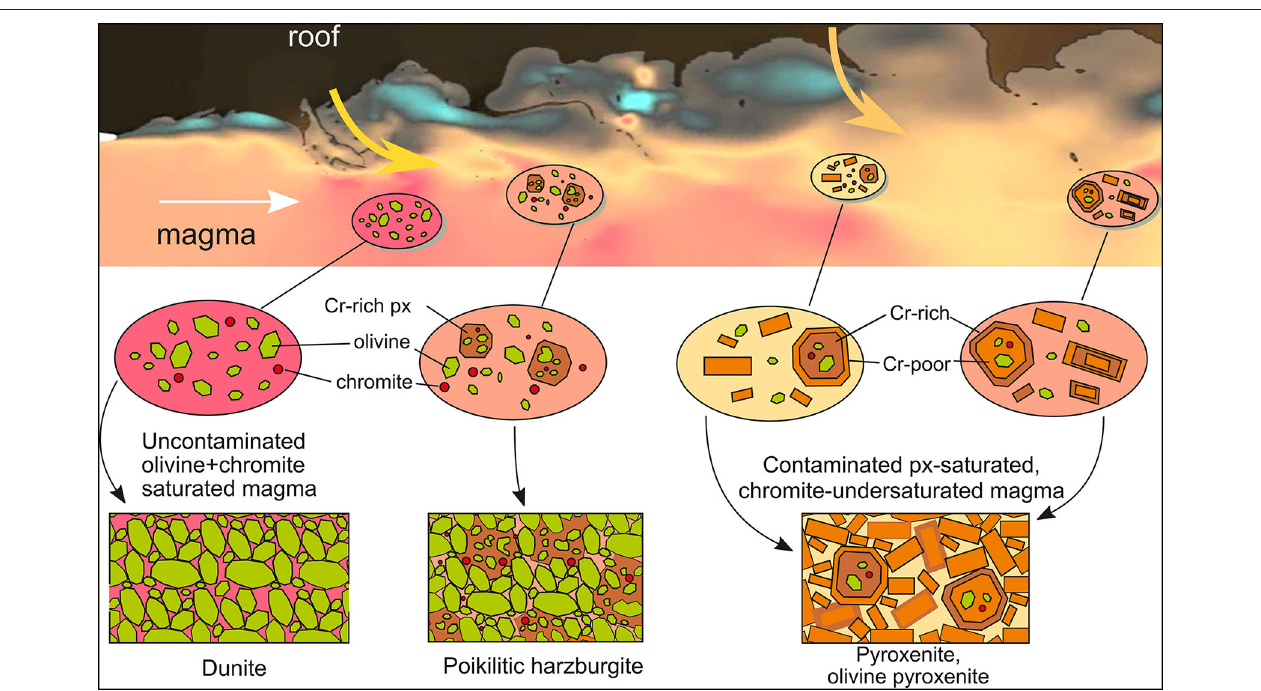
FIGURE 13 | The flowing magma assimilates the surrounding material, causing short-range transient fluctuations in composition, silica activity and redox state in poorly mixed magma. This allows for complex zoning of the mineral phases. sulfide mineralization can occur due to the assimilation of country rocks, therefore these zoning patterns can indicate high magma volumes required to form sulfide mineralization. Diagram modified from Barnes et al.